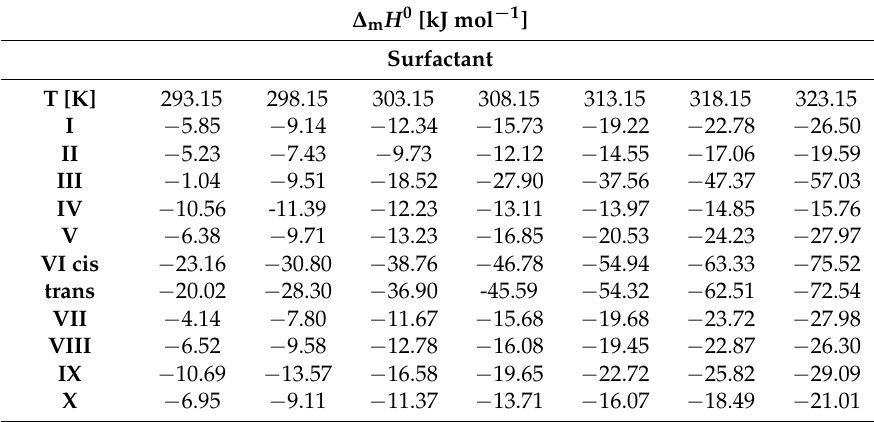
Table 8. Calculated values of standard molar enthalpy of micellization for all surfactant. solutions at temperature interval 20–50 ◦